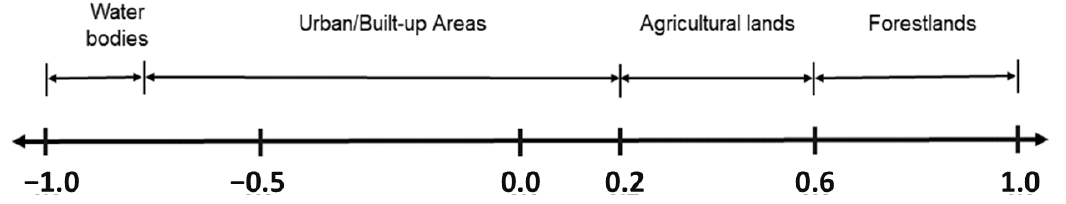
Figure 4. Diagrammatic representation of the LULC classes and their associated values.